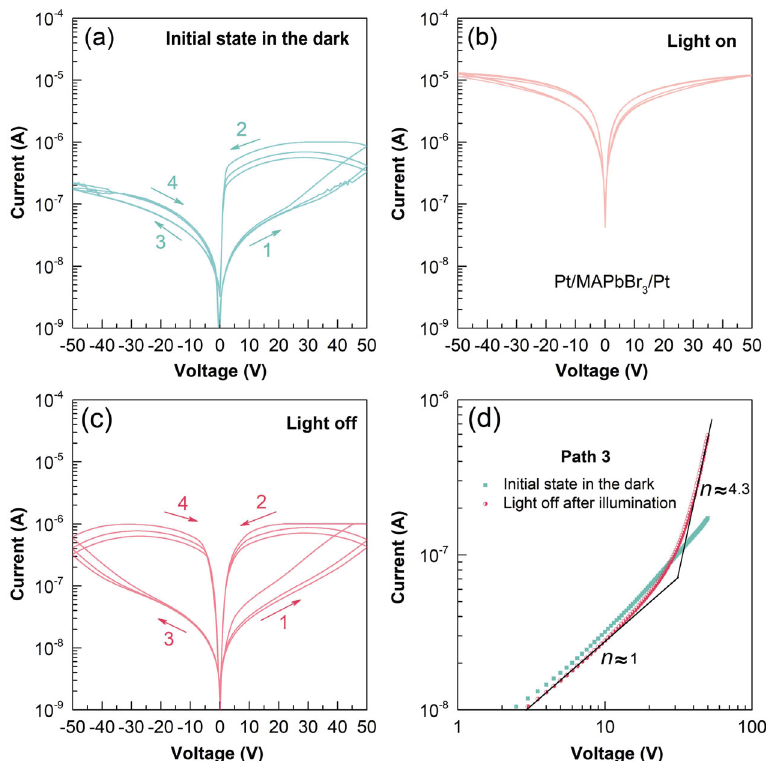
Fig. 6 I – V curves of a Pt/MAPbBr 3 /Pt device: (a) in the dark, (b) under light illumination (1500 lx), and (c) subsequent light off. (d) The so-called HRS (path 3 under reverse bias) of MAPbBr 3 single crystals with Pt electrodes in a log–log scale. Characteristic I – V traces in the initial dark state show only a linear ohmic regime ( I V  ), while a trap-filled regime ( could be found after light illumination.